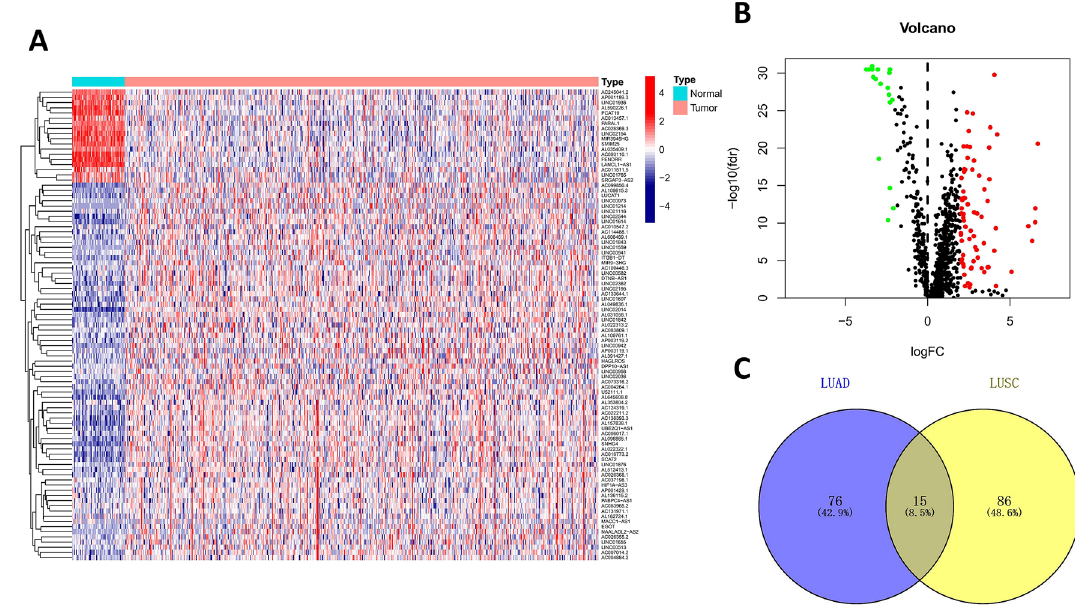
Figure 1. DEirlncRNAs between LUAD samples and normal controls. ( A ) The heat map of DEirlncRNAs. ( B ) The volcano plot of DEirlncRNAs. ( C ) The intersection of DEirlncRNAs between LUAD and LUSC. DEirlncRNAs, differentially expressed immune-related lncRNAs; LUAD, lung adenocarcinoma; LUSC, lung squamous cell carcinoma.